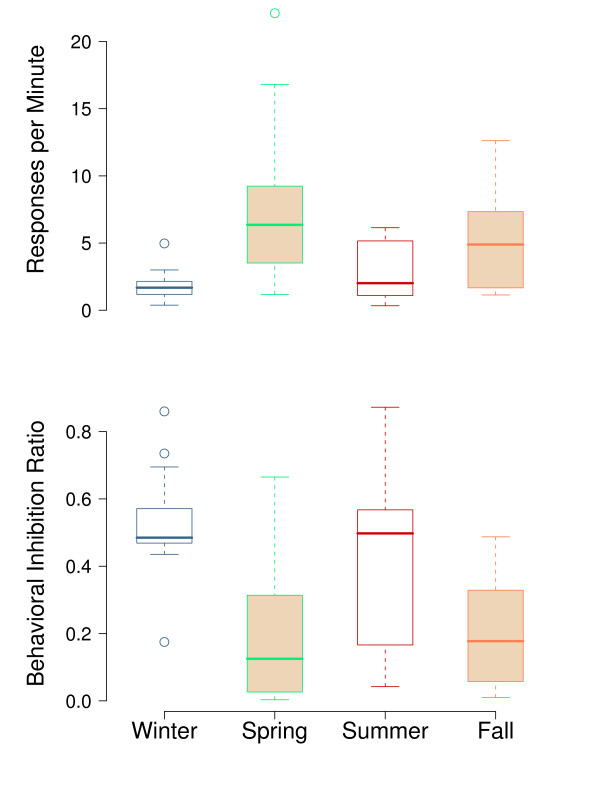
Box-and-whisker plots illustrating DRL performance during each season. Top shows response rate (responses/minute) and bottom shows the behavioral inhibition ratio (reinforcers/responses). Horizontal lines within boxes denote medians (50th percentile); horizontal edges of the boxes denote the 25th and 75th percentiles; whiskers extend to the 5th and 95th percentiles. Open symbols show the outliers. N = 15. Response rates are significantly higher during the migratory periods relative to the non-migratory periods and the behavioral inhibition ratio was significantly lower during migration. Operant data were analyzed for the same weeks, except in fall when operant animals were exposed to photoperiods ranging from 16.0:8LD - 11.5:12.5LD.